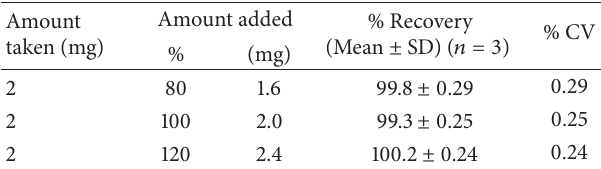
Table 2: Accuracy of the method.